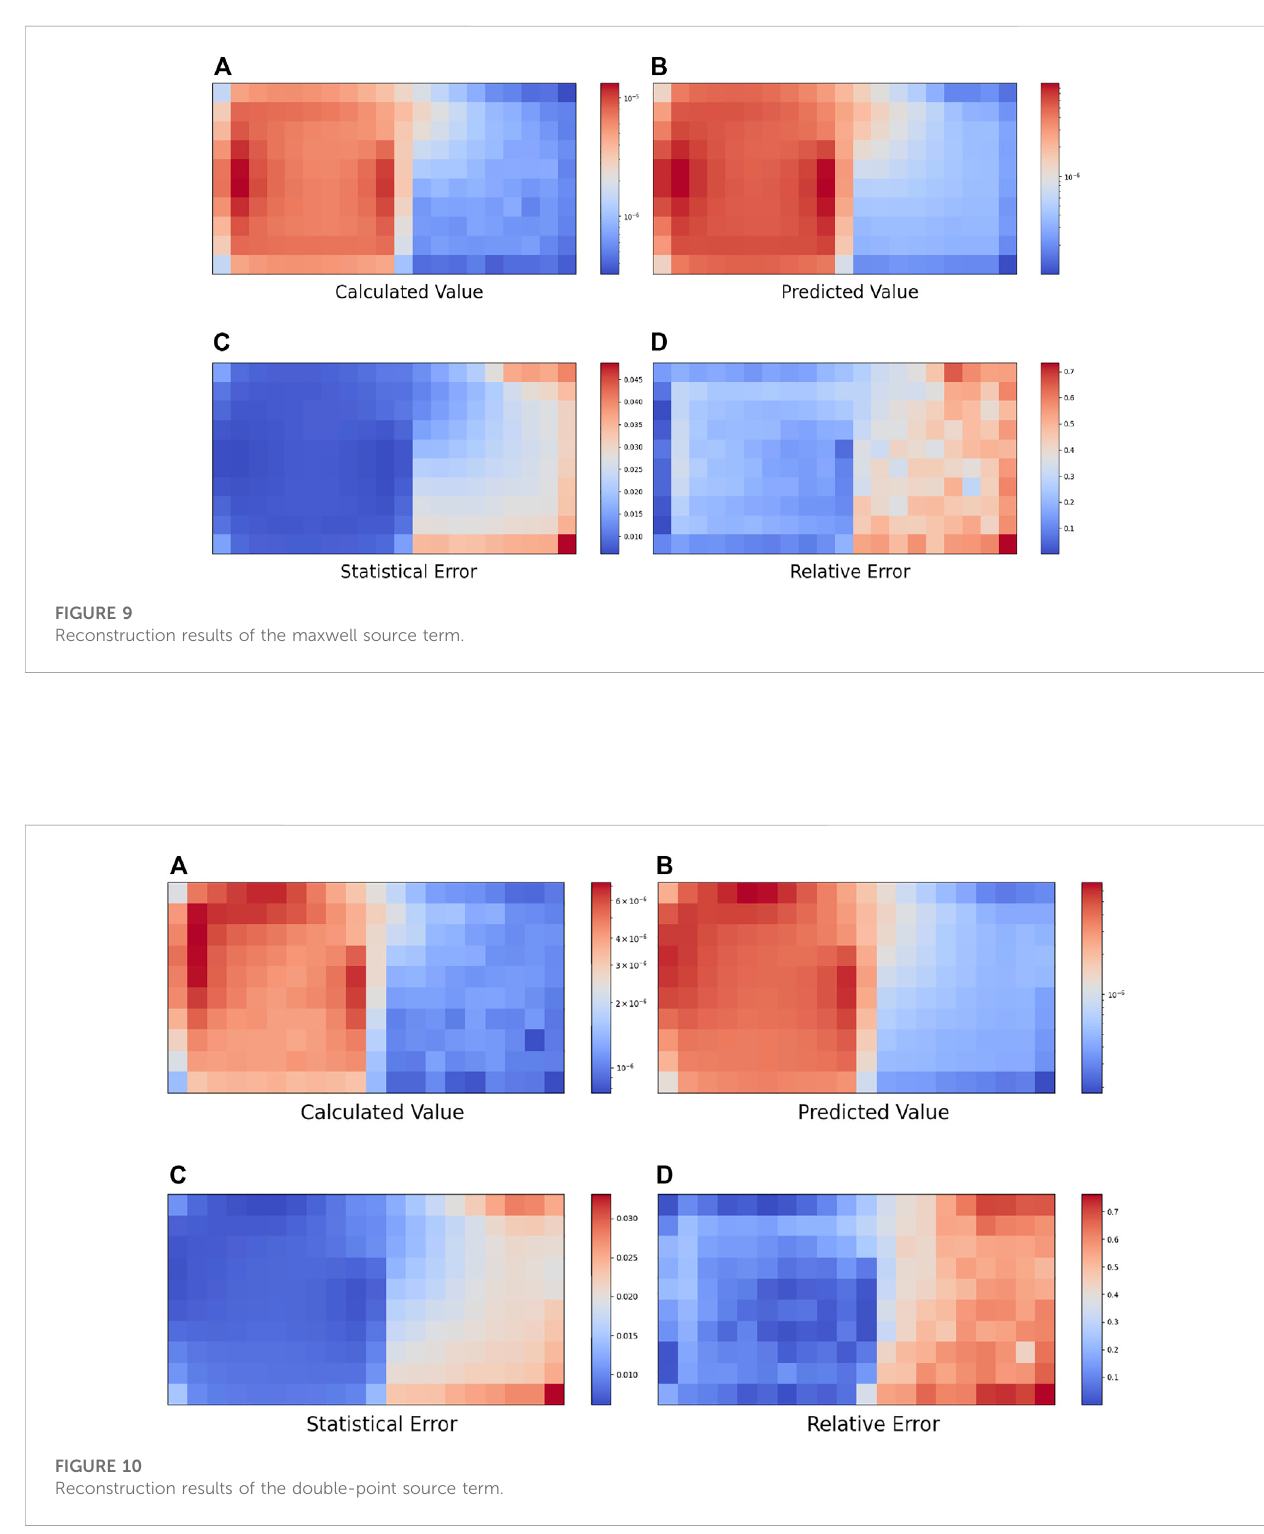
between batches was 2.79%. The average statistical error of the Monte Carlo calculation of the photon fl ux is 2.02%. The average relative deviation in the whole space MESH grid is 56.22%, and the average relative deviation in the MESH grid on the left side of the wall is 42.59%.